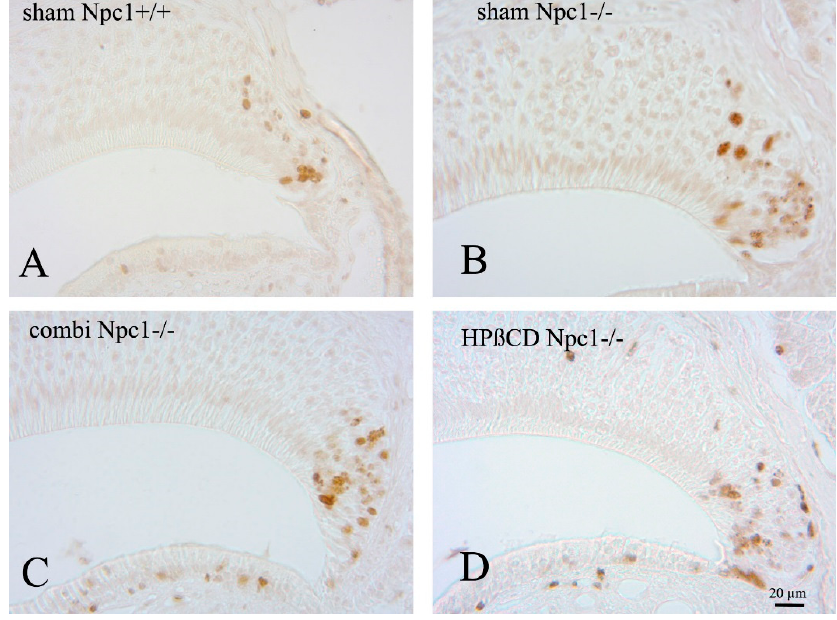
Figure 3. BrdU immunoreactivity of sham-treated Npc1 +/+ ( A ), sham-treated Npc1 − / − ( B ), combination- treated Npc1 − / − ( C ) and HP β CD-treated Npc1 − / − ( D ) animals. Whereas the structural integrity is maintained in all groups, the number of BrdU(+) cells is clearly increased in all mutant animal groups. ( A ) Most labeled nuclei belong to cells located in the boundary region between neuroepithelium and supporting cell layer; ( B – D ) mutant animals house BrdU(+) equally in all three layers (basal, intermediate and apical). Treated mutant mice also have increased cell numbers in the non-sensory epithelium.